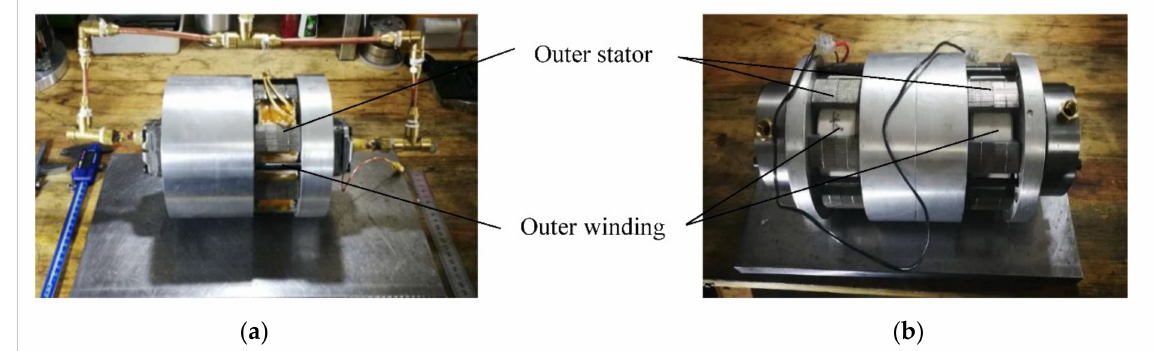
Figure 7. Prototypes of the proposed model 2 and model 3: ( a ) Prototypes of the proposed model 2; ( b ) Prototypes of the proposed model 3.